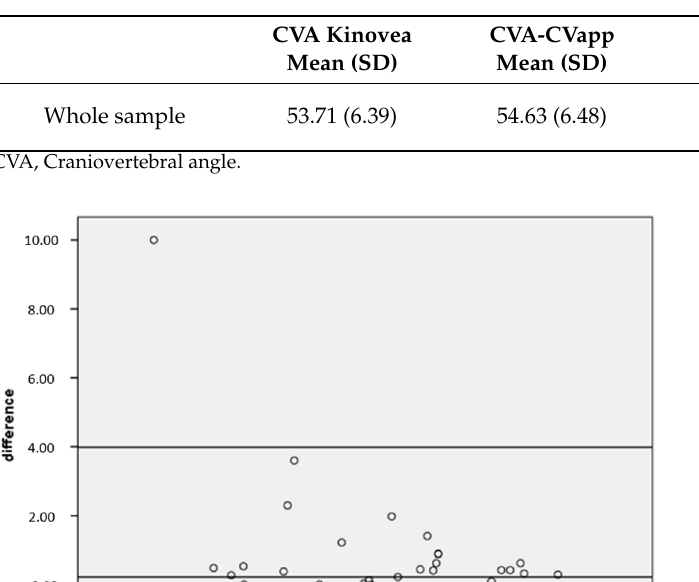
Table 4. Pearson’s r value between the Kinovea web tool and the CVA-CVapp. Table 4. Pearson´s r value between the Kinovea web tool and the CVA-CVapp.